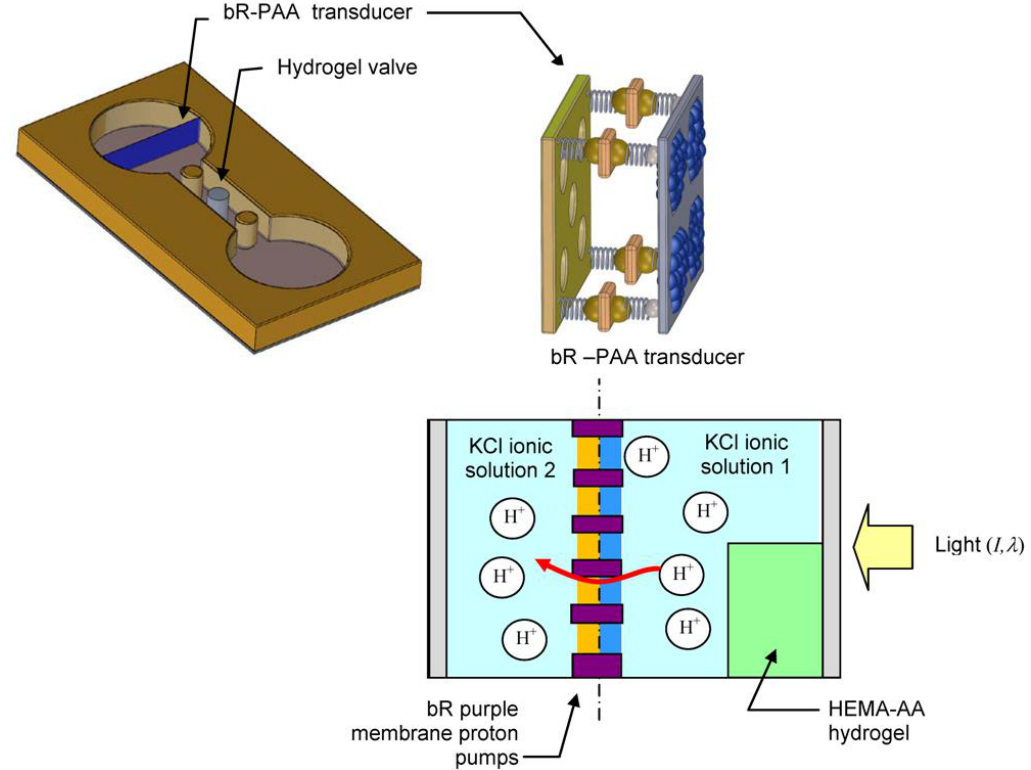
Figure 1. Illustration showing the insertion of the light-activated nano-porous bR-PAA transducer in a microfluidic chip reservoir and the basic mechanism for transporting H + ions between the two separated KCl ionic